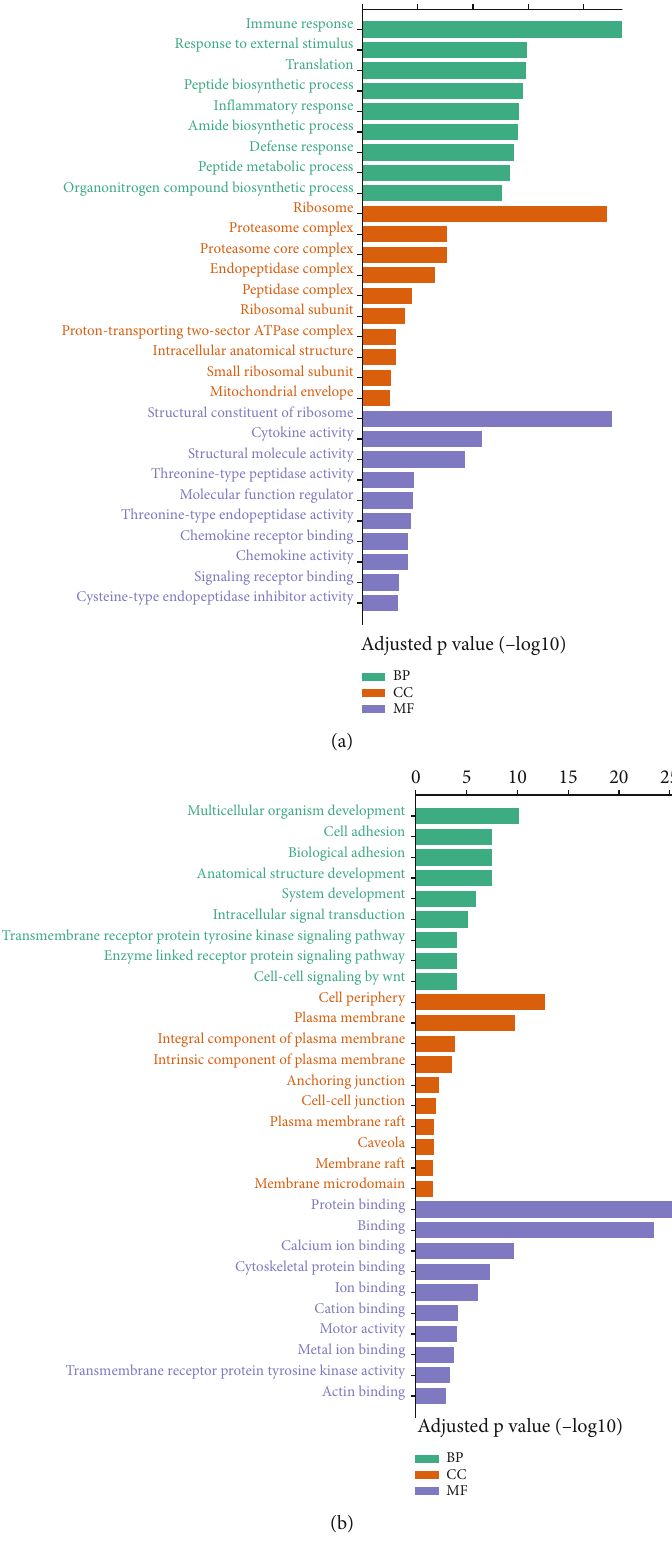
Figure 3: Gene Ontology (GO) enrichment analysis of di ff erentially expressed genes during K. pneumoniae infection. Biological process (BP), cellular component (CC), and molecular function (MF) of upregulated (a) and downregulated (b) genes between K. pneumoniae - infected lungs vs. normal lungs. The length of the bar represents -log10 adjusted P